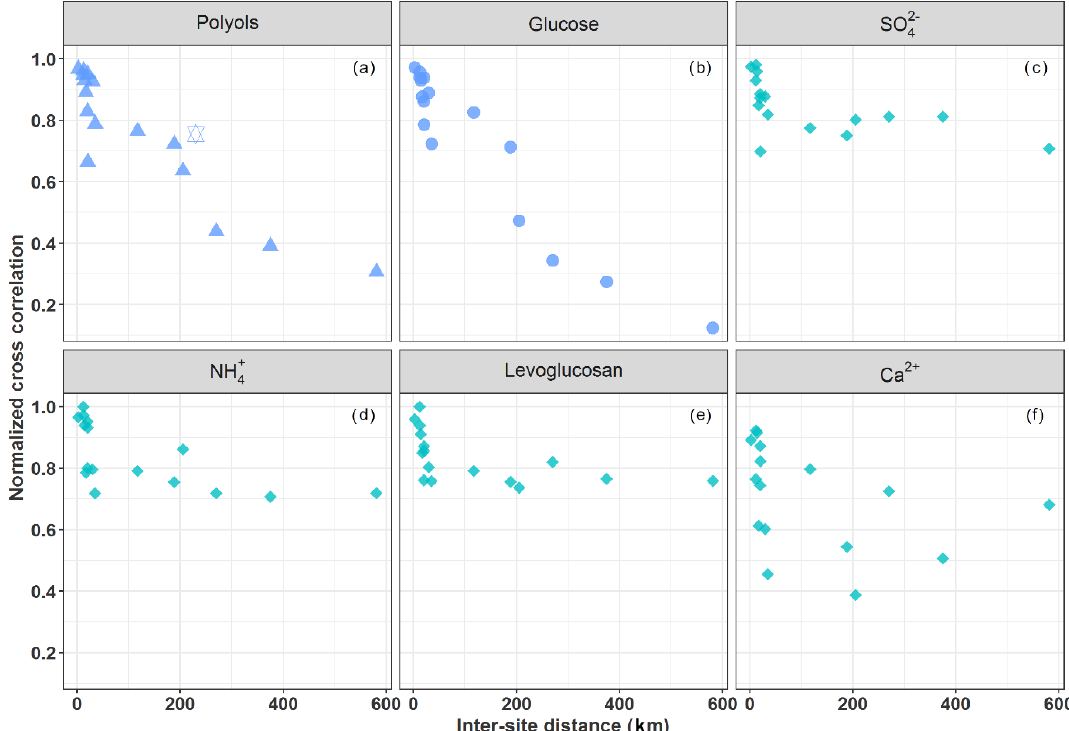
Figure 3. Normalized cross-correlation values for the daily evolution of particulate polyols (a) , glucose (b) , sulfate (c) , ammonium (d) , levoglucosan (e) , and calcium (f) concentrations over pairs of sites located at multiple increasing space scales across France. The hexagram corresponds to the correlation between the sites of OPE-ANDRA and Nogent-sur-Oise, both sites being surrounded by crop field